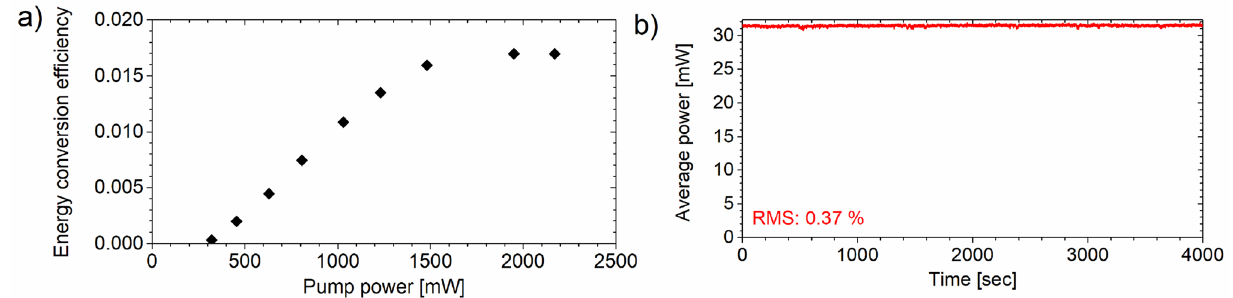
Figure 4. ( a ) Pump-to-idler energy conversion efficiency at 10.6 μm as a function of average pump power at 1.028 μm. The pump power was not corrected for Fresnel losses at the front face of the uncoated OPA crystal and the MIR power was measured at the output after the germanium lens. ( b ) Average power stability of the idler beam at 10.6 µm as a function of